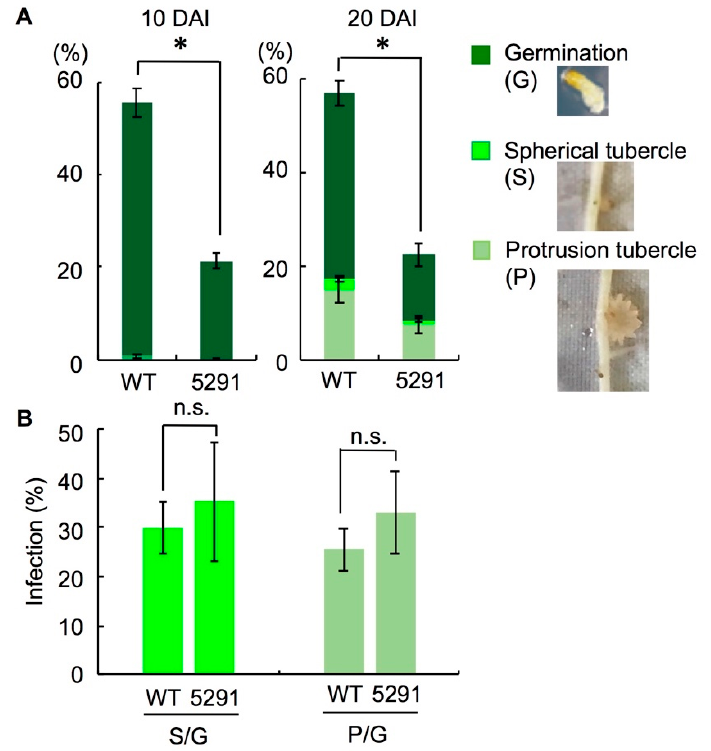
Figure 7. Infection assay with Phelipanche aegyptiaca . ( A ) Proportion of germinated P. aegyptiaca seeds, spherical tubercles, and protrusion tubercles 10 and 20 days after inoculation (DAI) of tomato roots ( n = 3). ( B ) Infection with germinated P. aegyptiaca seeds 20 DAI ( n = 3). S/G and P/G mean frequency of spherical tubercles and protrusion tubercles to germinated Phelipanche, respectively. Error bars, S.E.; * p < 0.05 (Student’s t -test); n.s., not significant.